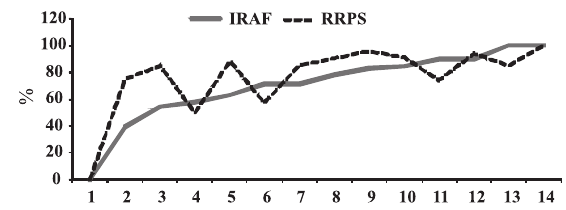
Figura 4. Redução relativa de perda de solo (RRPS) em função do incremento relativo de área de floresta (IRAF) para os diferentes cenários estudados.